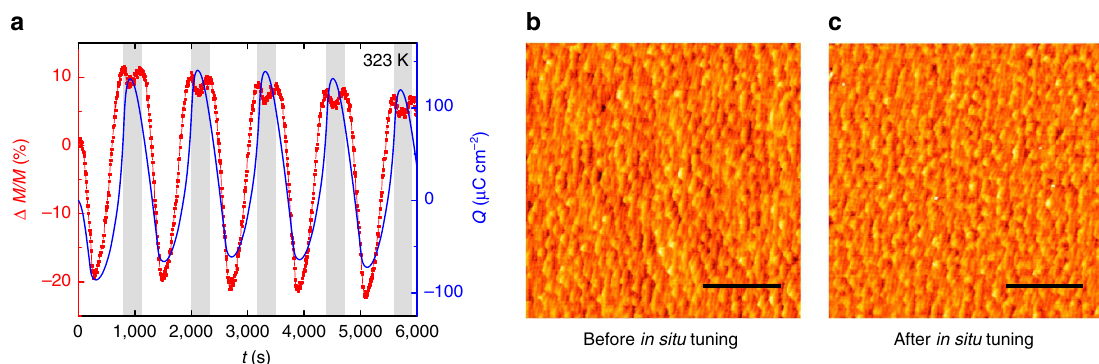
Figure 6 | Tuning of magnetism in proximity of T C and LSMO surface characterization. ( a ) Time-resolved magnetic response featuring a E 33% tuning effect on modulation of the surface charge density ( D Q E 200 m Ccm (cid:2) 2 ). The expected in-phase response (white area) of M ( t ) with respect to Q ( t ) reveals an anti-phase splitting (grey area) on the hole doping branch, akin to the behaviour encountered below T cross for a small potential window. ( b , c ) Atomic force micrographs of the LSMO surface before ( b ) and after ( c ) in situ tuning. In both b , c , scale bar, total height scale root-mean-square roughness are about 1 microm, 1.5 nm and 0.2